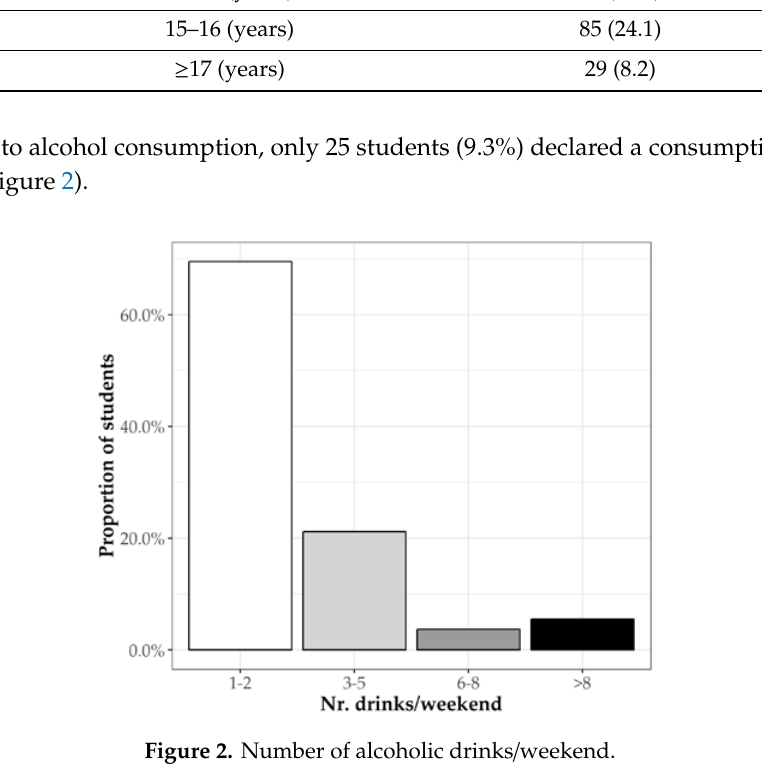
Figure 3. ( a ) Frequency of cannabis consumption among students and ( b ) the association between alcohol and cannabis consumption.